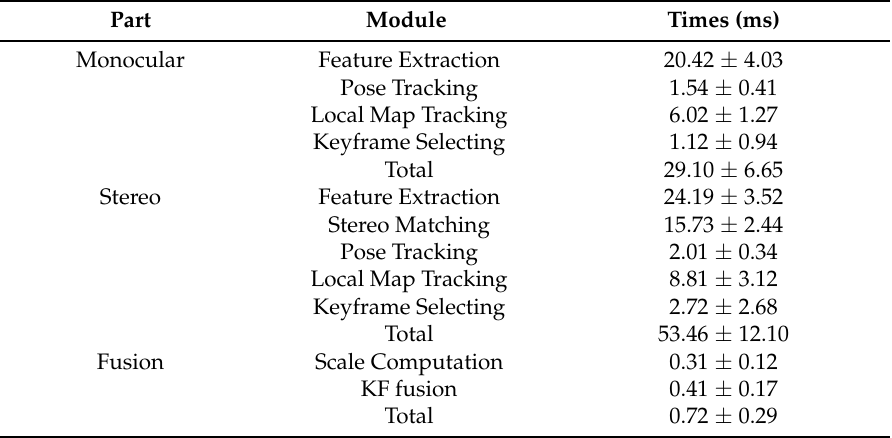
Table 5. Consuming Time Results of Our Proposed Method in Oxford Robotcar